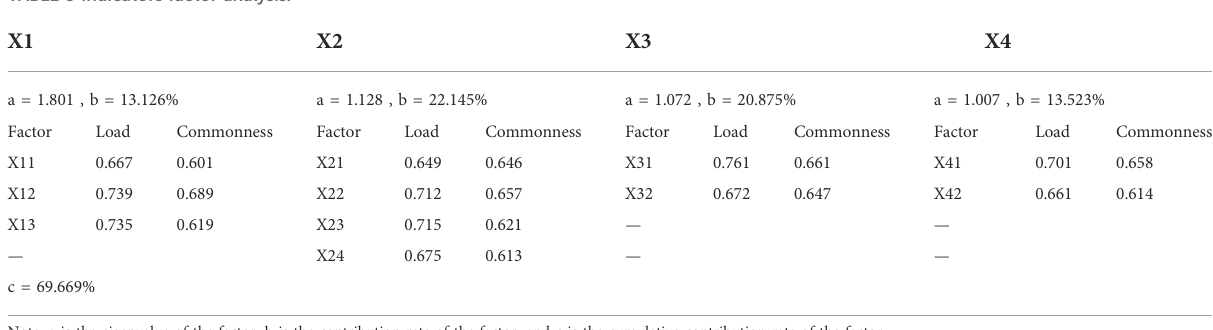
TABLE 3 Indicators factor